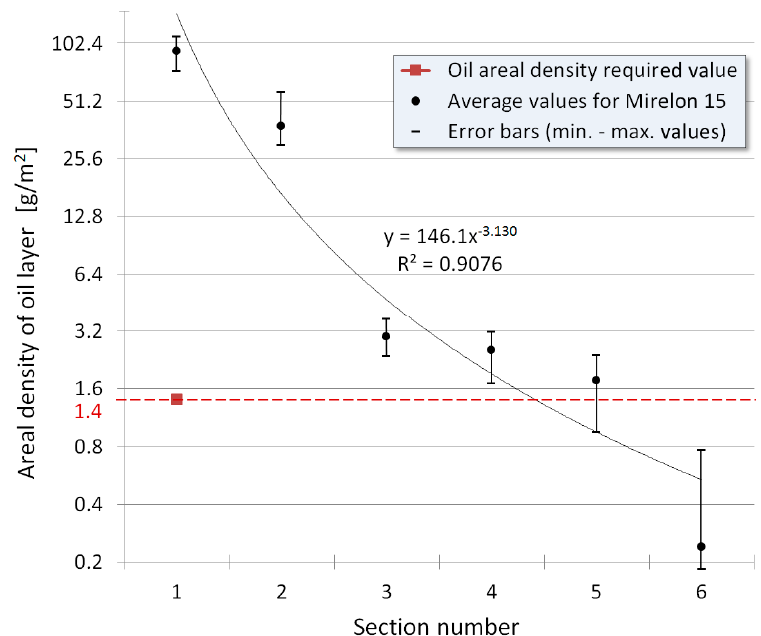
Figure 17. Graphical representation of average oil film weights in individual sections of the Mirelon 15 coated pipe. Data is downloaded from Table 1. The graph contains a trend line with an estimated power function and a corresponding confidence equation R.